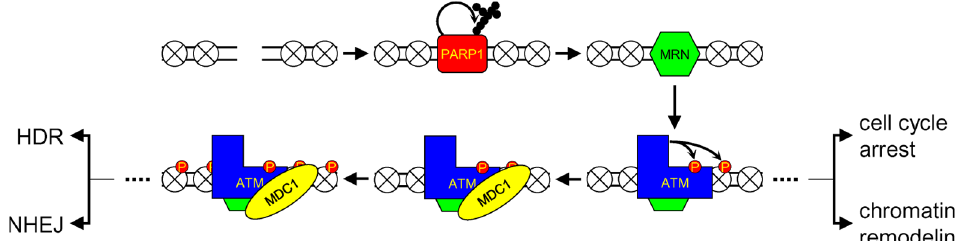
Figure 3. Scheme of initial events during DSB sensing. PARP1 senses the damage, self-modifies, and recruits MRN. MRN in turn attracts ATM, which phosphorylates (red circles) itself and H2AX in the surrounding nucleosomes (crossed circles). MDC1 binding helps spread H2AX phosphorylation over the adjacent regions of chromatin.